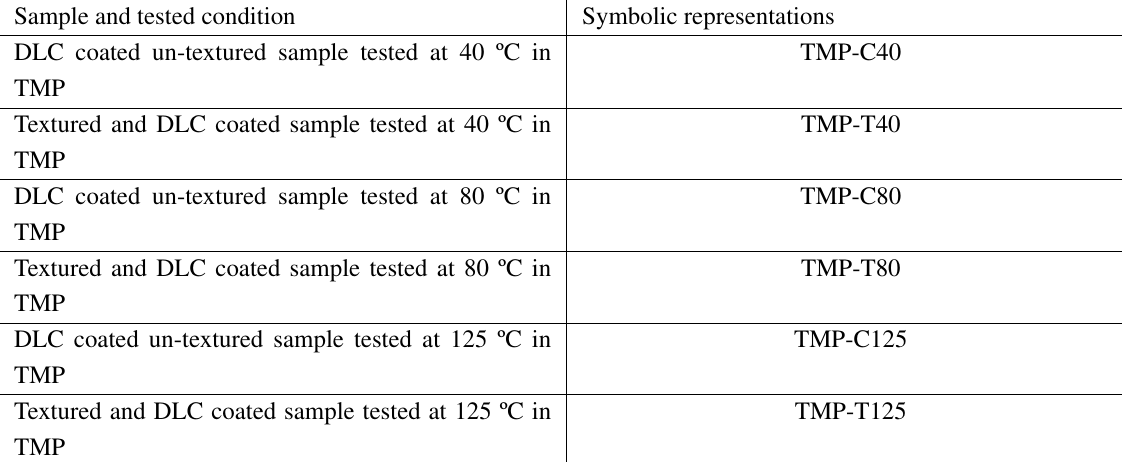
Table 1. Symbolic representations used in the present